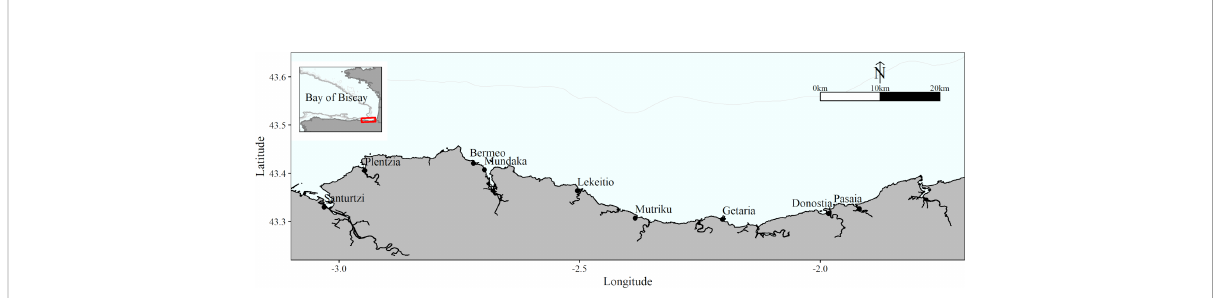
FIGURE 1 Area of study where recreational fi shing activity data was collected. Red box in the upper left small map indicates the zoomed region of the Bay of Biscay presented in the main panel. The most important harbors are indicated within the map. Grey lines represent the 200m (the closest to the shore, visible in both maps), 500m and 1000m